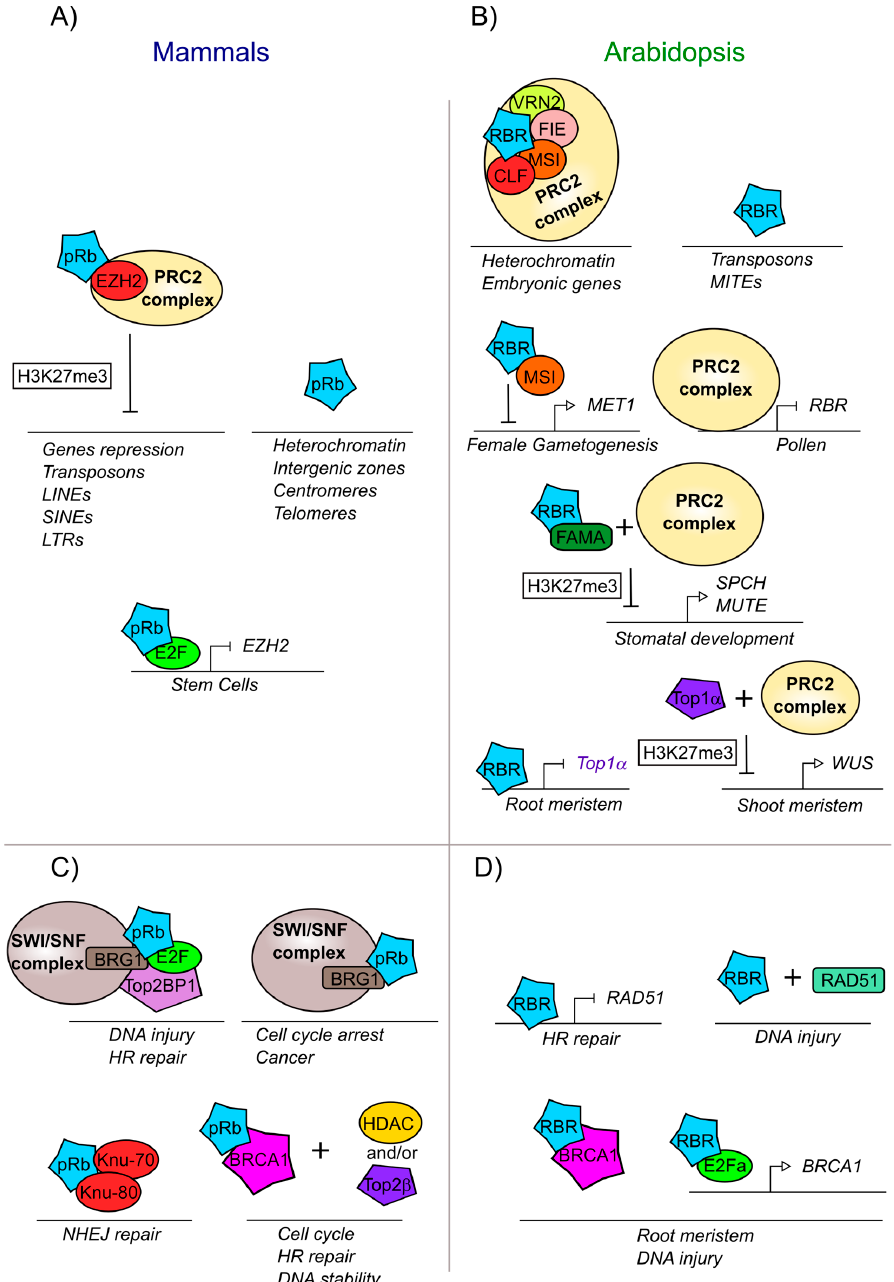
Figure 4. pRb and RBR are involved in modifications and DNA repair mechanisms both in mammals and plants. ( A ) Mammalian pRb participates in developmental processes and chromatin localization together with EZH2, a component part of the PRC2 complex. ( B ) Arabidopsis RBR participates in development and chromatin localization together with the PRC2 complex. ( C ) Mammalian pRb is part of the machinery involved in DNA repair. ( D ) Arabidopsis RBR is part of the machinery involved in DNA repair. Proteins and complexes conserved between mammals and Arabidopsis are marked with the same colors. In plants, there are also numerous reports of RBR interactions with epigenetic modifiers, which are important in the regulation of different developmental processes [277]. In Arabidopsis, like in